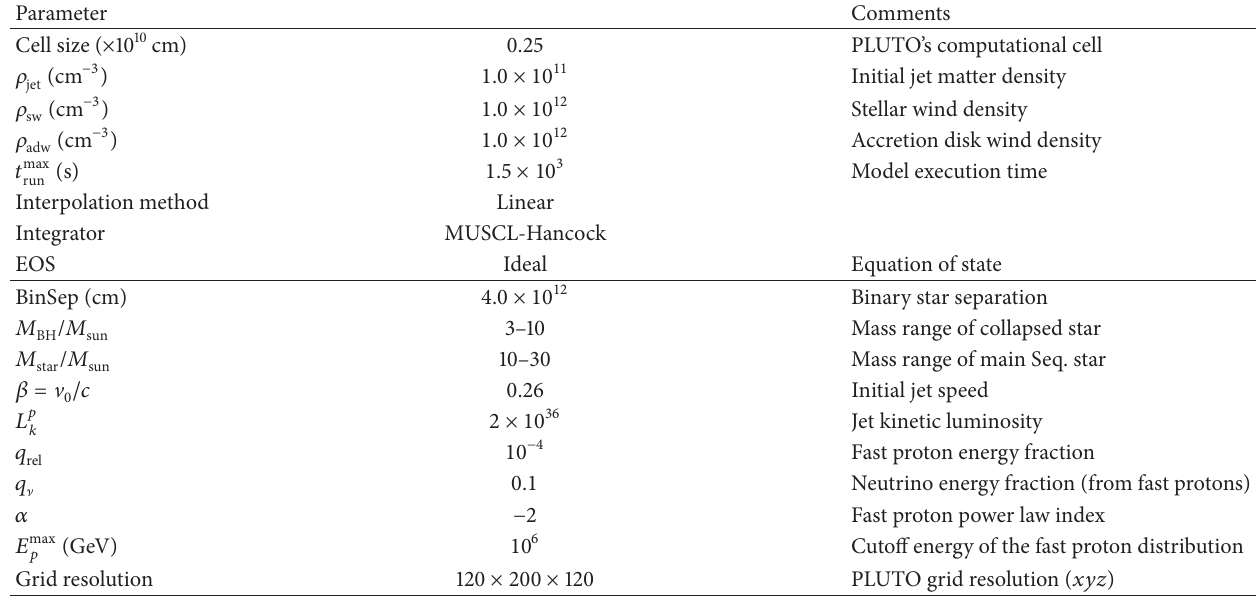
Table 1: Values of various physical and model parameters pertaining to the 𝛾 -ray emission from the jet, for the simulation run, obtained with the linear method and the Hancock